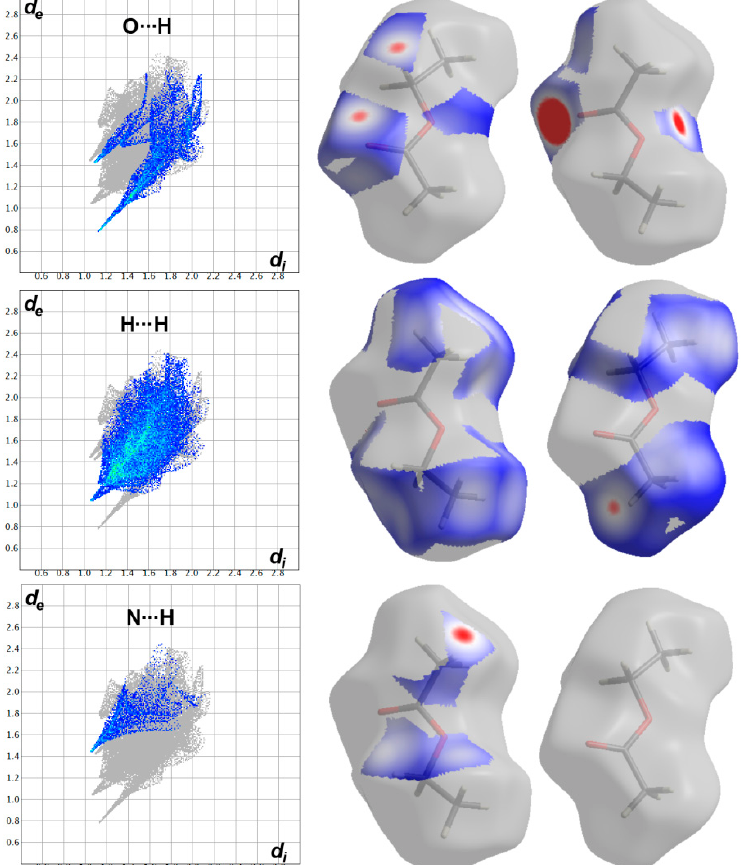
Figure 6. The fingerprint plots and d norm maps for the short contacts in the crystal solvent in the crystal structure of 6c .